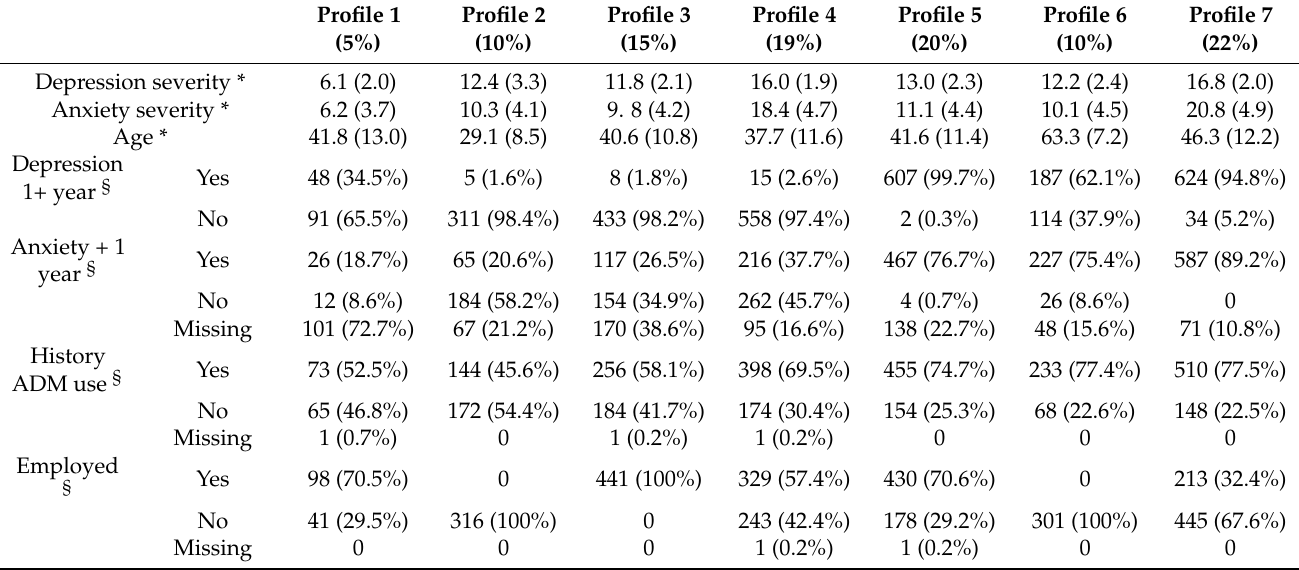
Table 3. Descriptive statistics for baseline variables in each identified